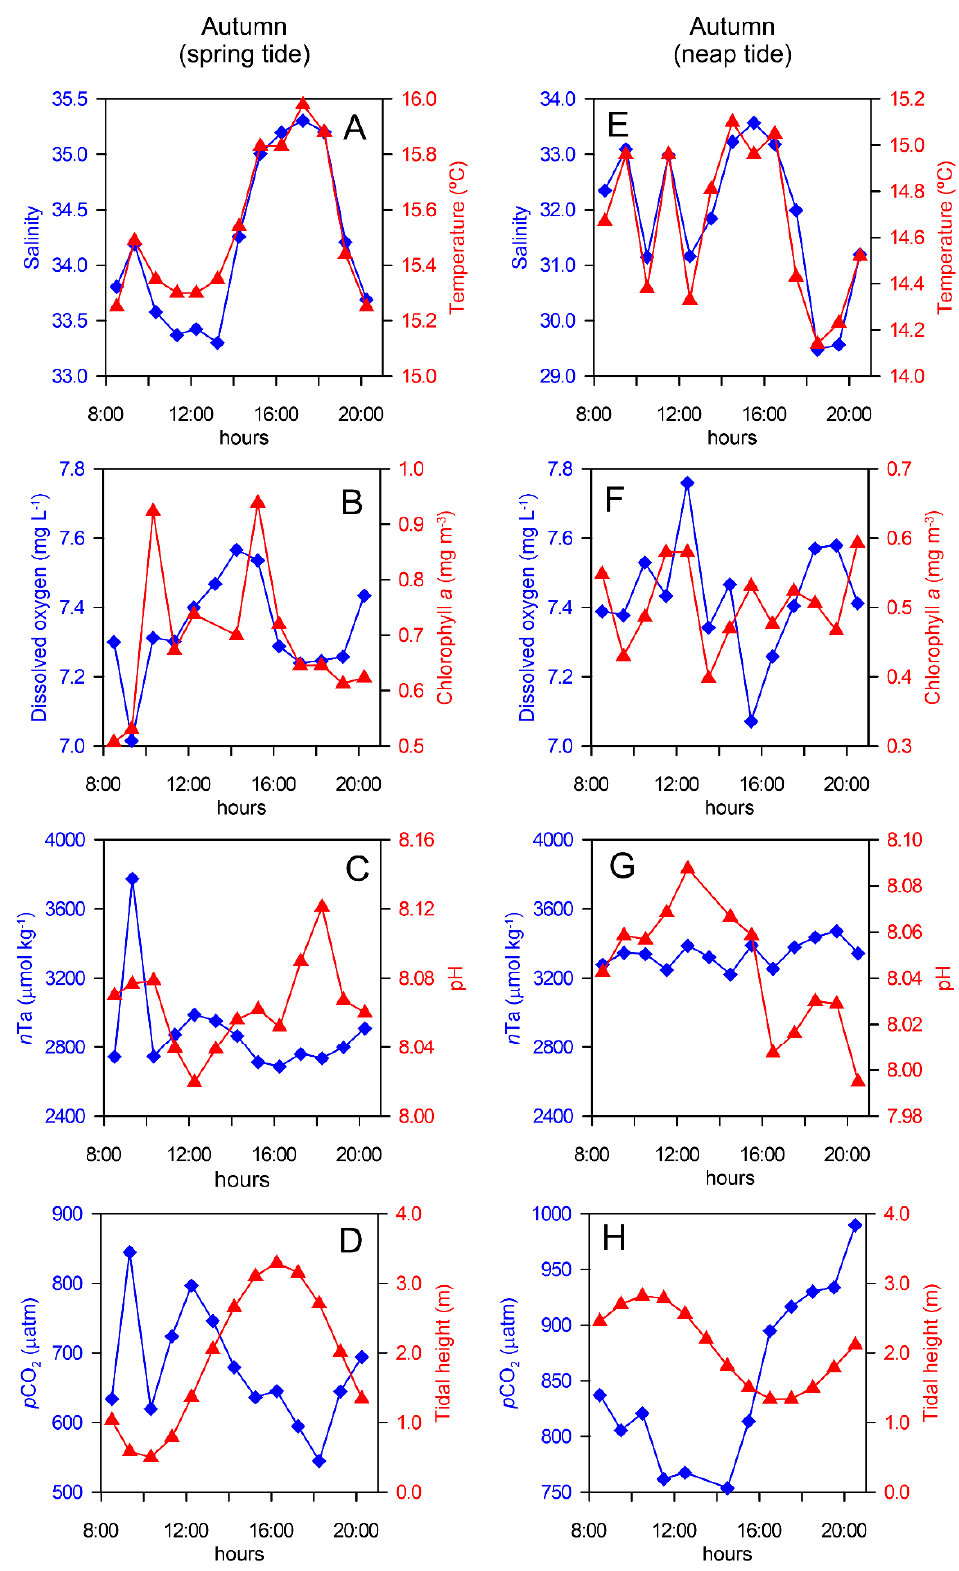
Figure 3. Tidal variation of: ( A , E ) salinity and temperature, ( B , F ) chlorophyll a and dissolved oxygen, ( C , G ) normalized alkalinity ( n TA) and pH, and ( D , H ) CO 2 partial pressure ( p CO 2 ) and tidal height, in spring and neap tide in the Tagus fixed station, for autumn 2007.